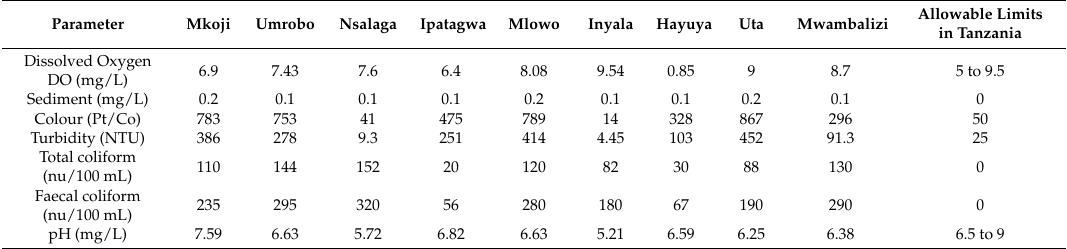
Table 2. Water quality in the different areas in the catchment and their allowable